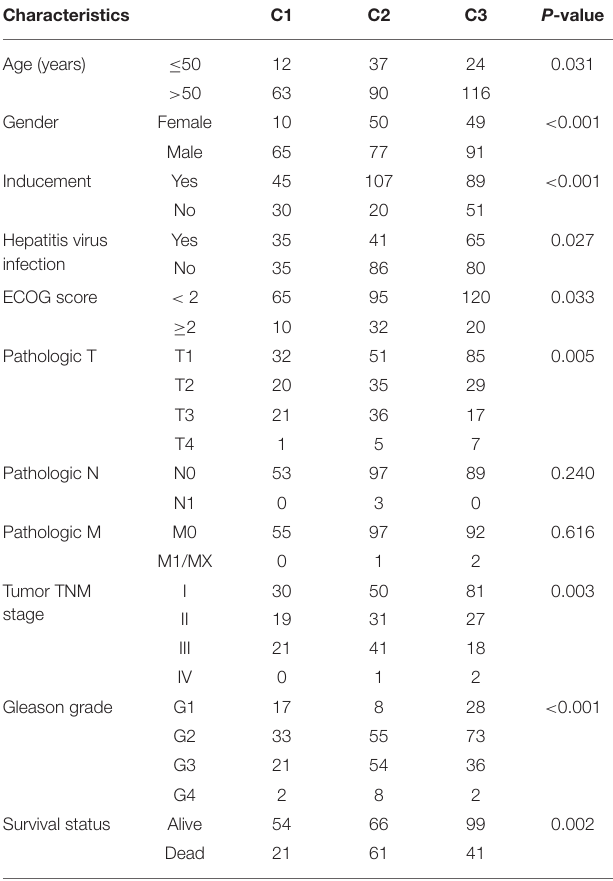
TABLE 2 | Clinicopathological characteristics among three molecular